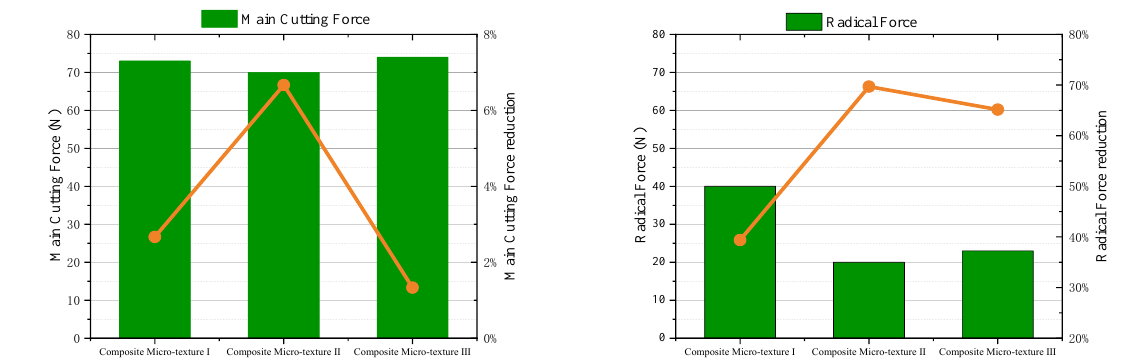
main cutting edge, and the stress value is the smallest. It can be concluded that the stress absorption effect of composite micro–texture II is significantly better than that of the other two micro–texture tools.